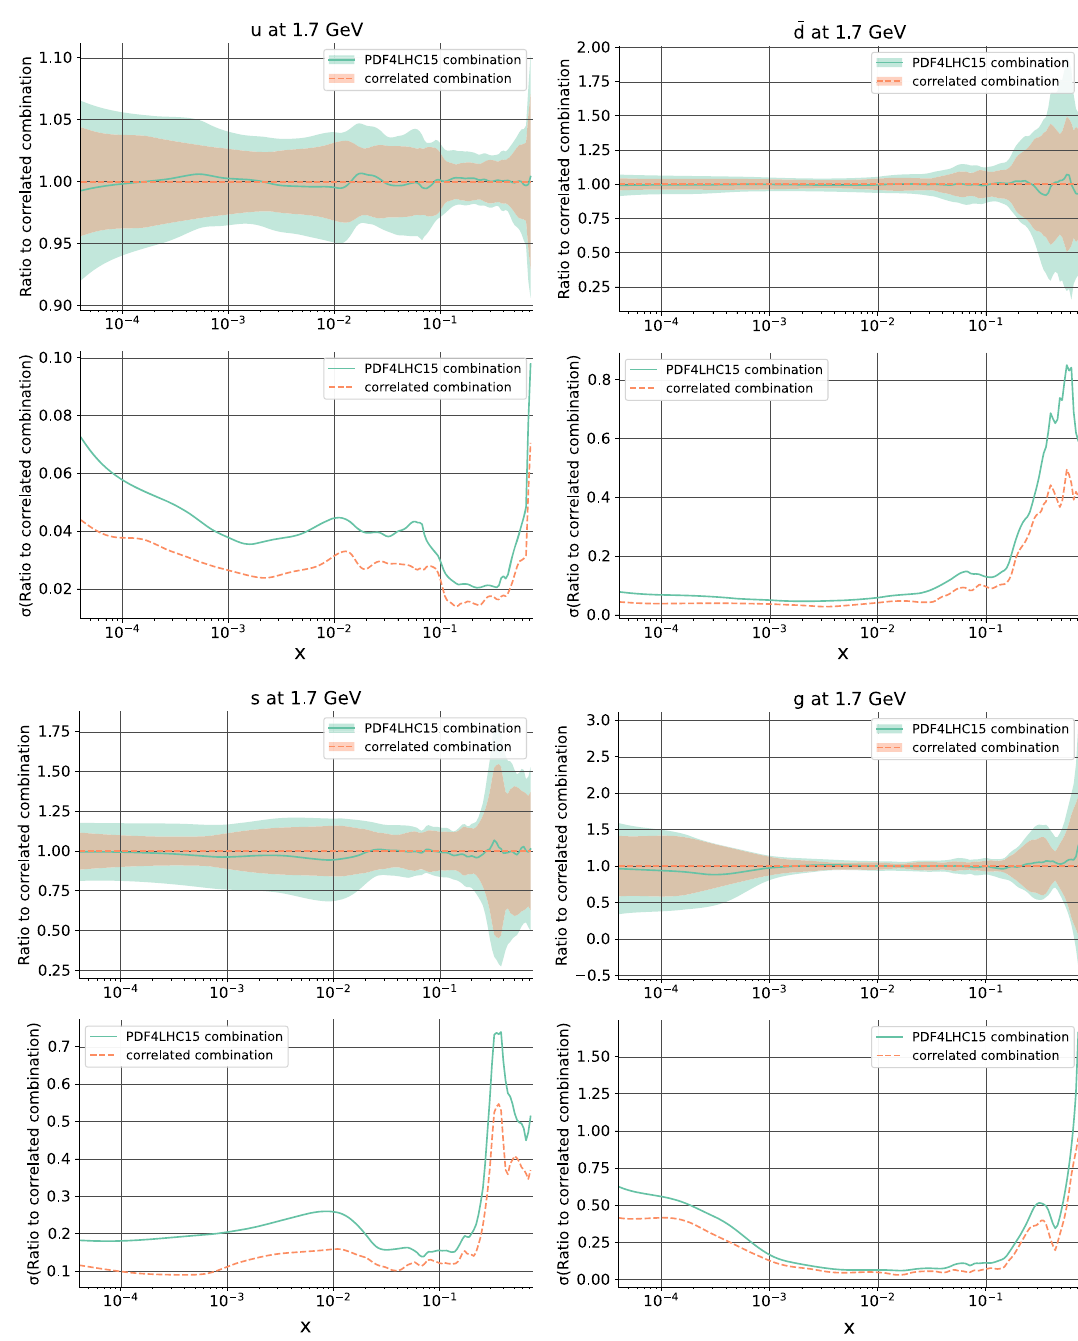
related weighted average of the ten results Eq. (21) (same as shown in Fig. 7); the PDF4LHC15 combination is found by simply combining all replicas in a single 430-replica